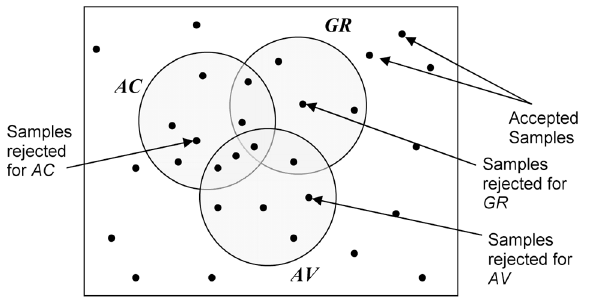
Fig. 1. Samples acceptance and rejection